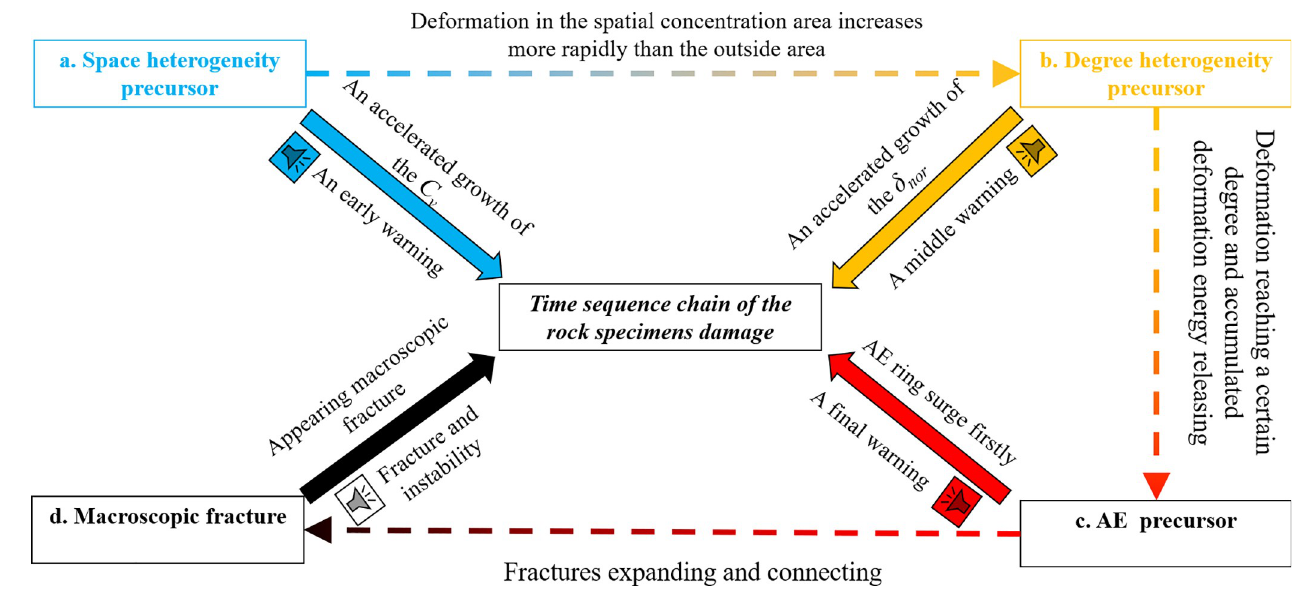
Fig 9. Time sequence chain of the C